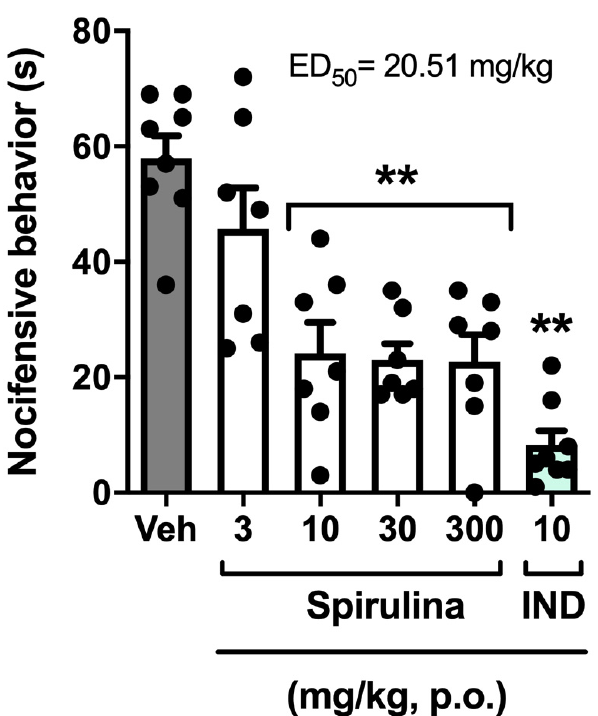
Figure 2. Effect of Spirulina on nocifensive behavior induced by intraperitoneal injection of acetic acid in mice. Each column represents the mean ± SEM of 7–8 animals/group, with a black dot showing individual mice. Asterisks denote the levels of significance compared to the vehicle group (Veh). ** p < 0.001 using one-way ANOVA. IND: indomethacin.